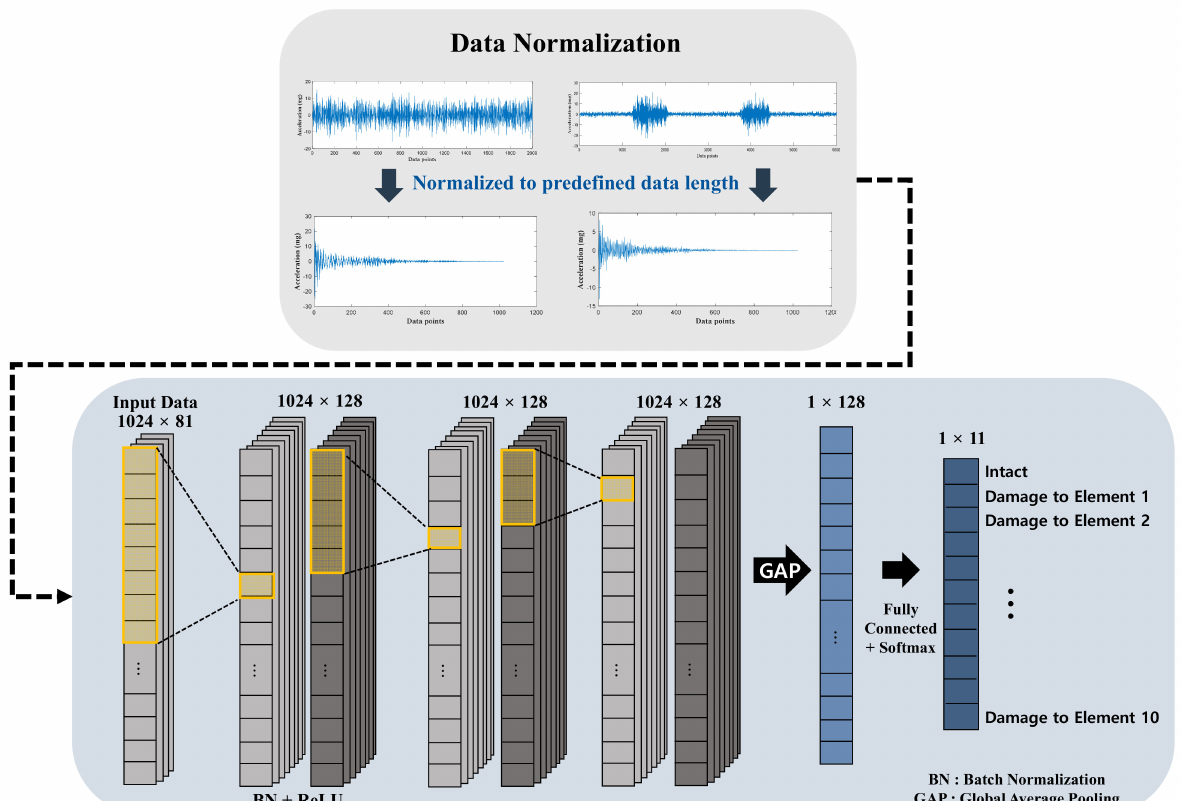
Figure 2. One-dimensional convolutional neural network